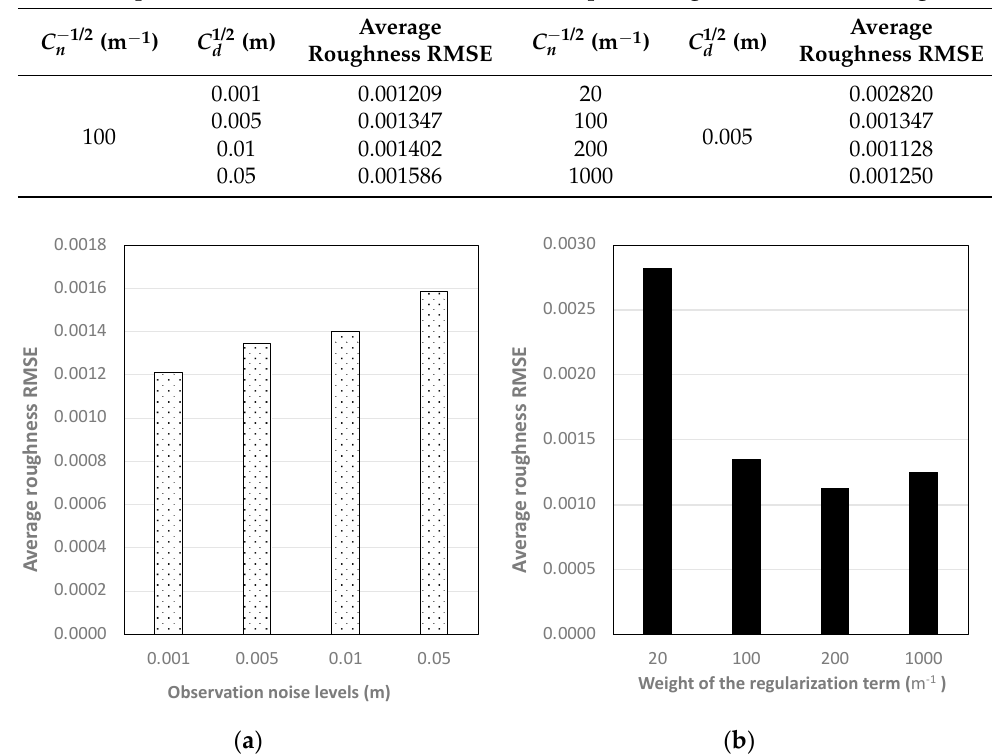
Figure 9. Average roughness RMSE at different ( a ) observational-noise levels and ( b ) weights of the regularization term.